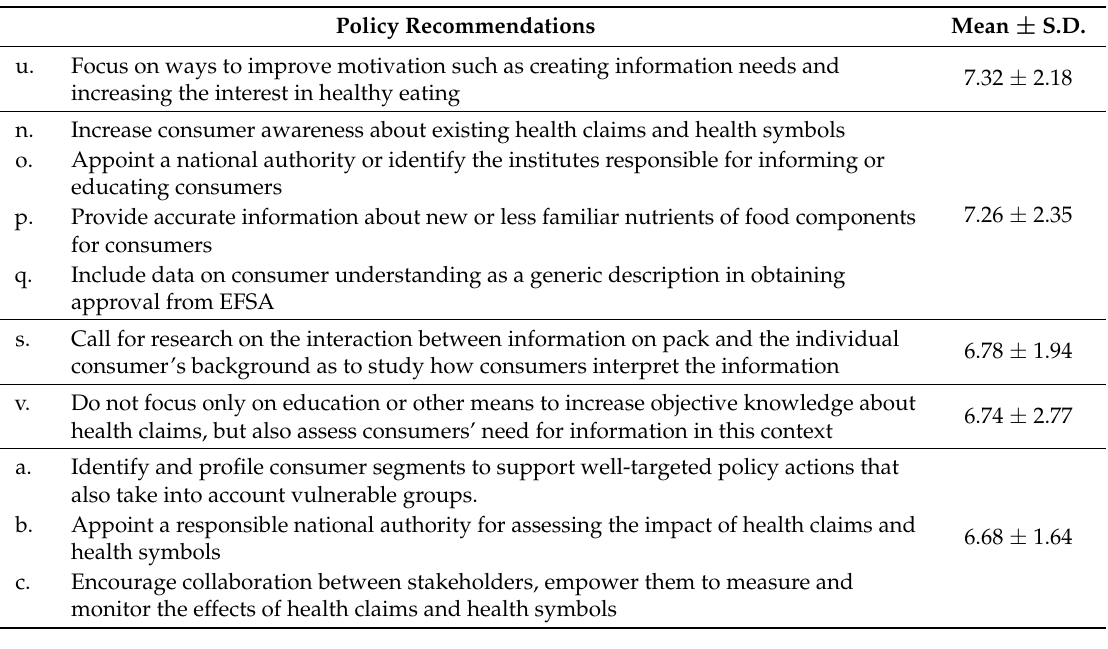
Table 2. Policy recommendations ranked based on the aggregated mean scores from the five criteria of evaluation in descending order ( n =